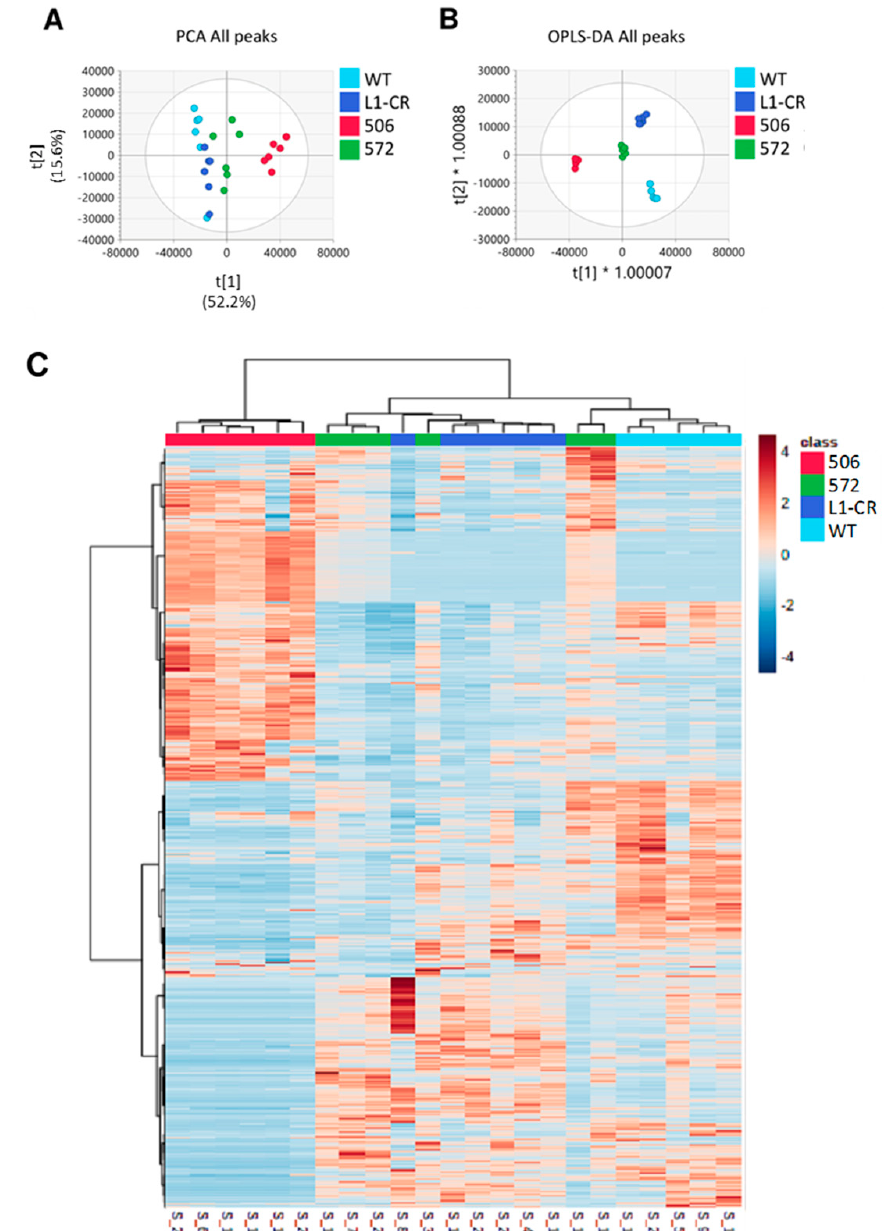
Figure 3. Comparison of RT4 cells and ALDH1L1-deficient clones based on all peaks from untargeted metabolomics data. PCA ( A ) and OPLS-DA ( B ) between all groups with the CRISPR and 572 clones clustered closely (R2X: 0.920, R2Y: 0.981, Q2: 0.808). ( C ) A heat map (generated using MetaboAnalyst 5.0 [26]) of measured metabolites (13,339 total, Supplementary File S1) demonstrates significant differences between groups’ metabotypes, with WT RT4 cells and clone 506 being most distant and CRISPR and 572 clones being the farthest apart. The heatmap is auto-scaled (mean-centered and divided by standard deviation) for each variable; n = 5 per group (RT4 cells) and 6 per groups for each clone. Orange colors represent higher auto-scaled values whereas blue colors represent lower auto-scaled values. Colors for experimental groups are as follows: 506, red; 572, green; L1-CR, dark blue; WT, cyan. Hierarchical clustering was performed on samples in MetaboAnalyst 5.0 using Euclidean distance measures. Each sample number (as in Supplementary File S1) is indicated at the bottom of the